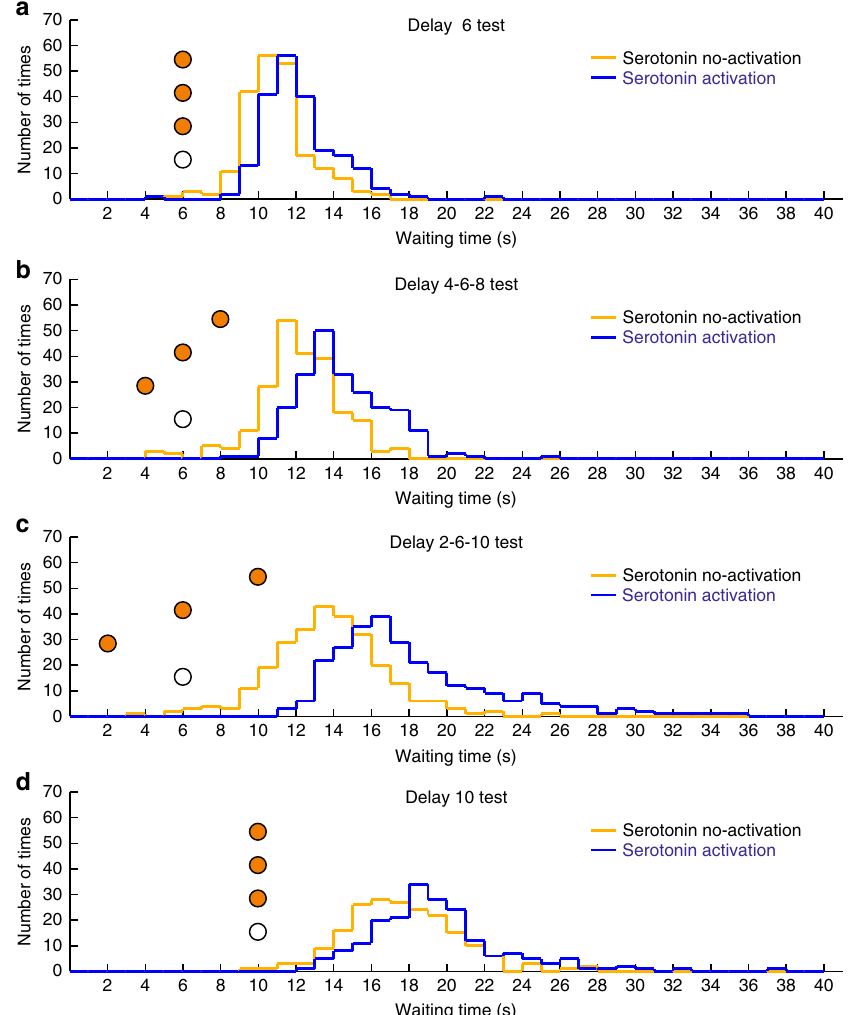
Fig. 5 Optogenetic activation of DRN serotonin neurons enhances waiting for temporally uncertain rewards. a Distribution of waiting time during omission trials in the D6 test. b Distribution of waiting time during omission trials in the D4-6-8 test. c Distribution of waiting time during omission trials in the D2- 6-10 test. d Distribution of waiting time during omission trials in the D10 test. Orange circles illustrate the timing and number of food pellets presented in rewarded trials. White circles denote omission